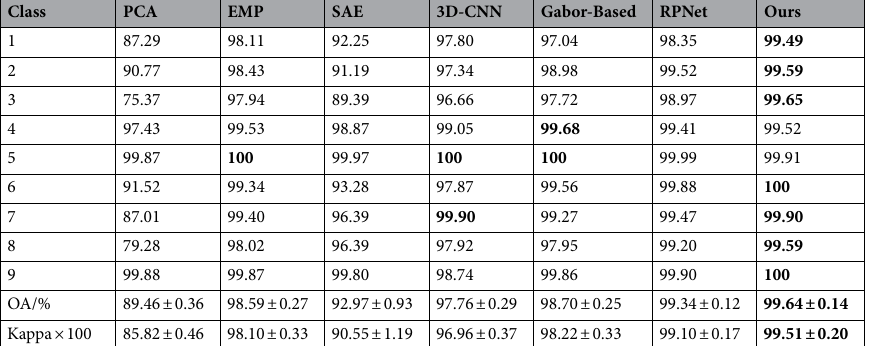
Table 5. Classification accuracy of Pavia University